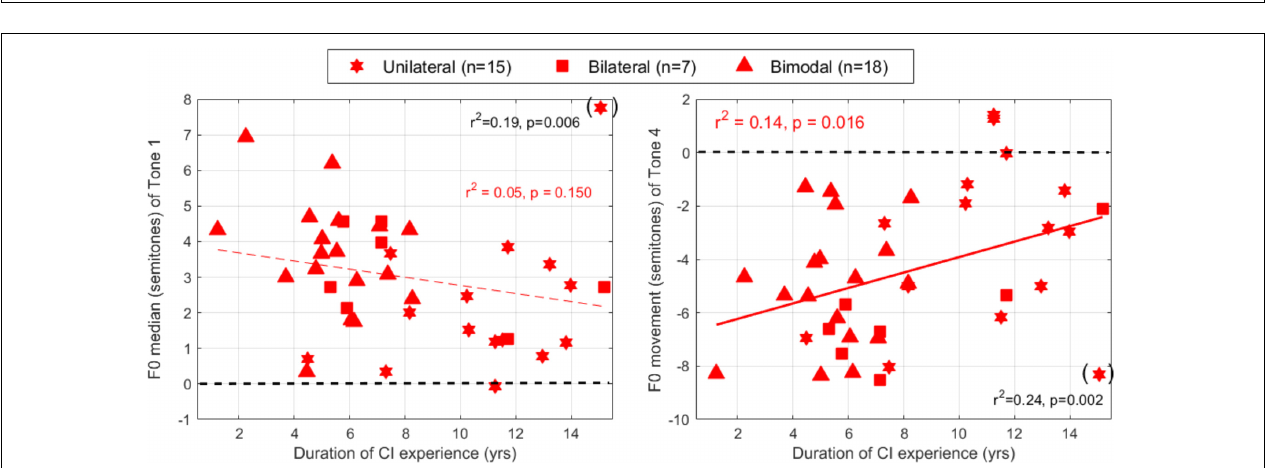
FIGURE 7 | F0 median for Tone 1 (left) and F0 movement for Tone 4 (right) plotted across participants as a function of their years of CI use. The CI participants who had used their CI for the longest time exhibited less modulation of their vocal chords either to differentiate the pitch range between syllables (as in the case of Tone 1) or to indicate the direction of a pitch sweep (as in the case of Tone